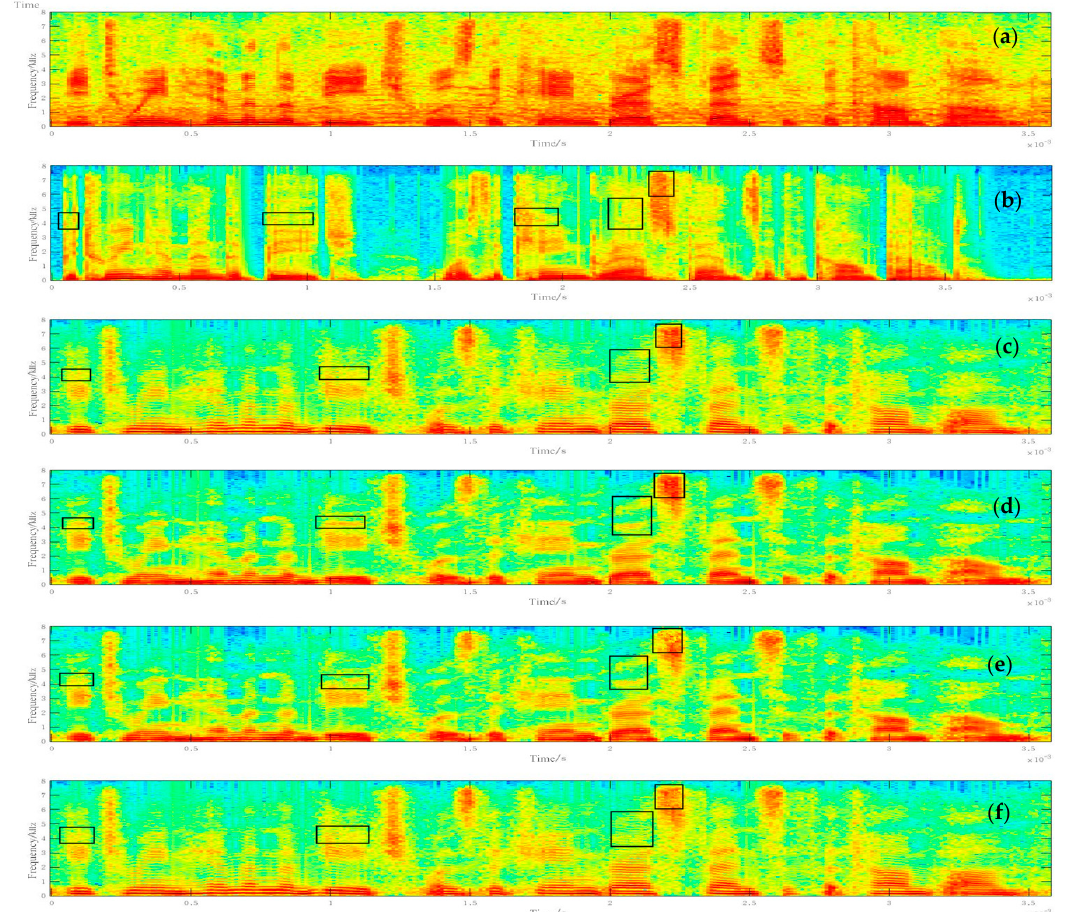
Figure 6. Spectrogram of the methods of voice conversion: ( a ) source voice with babble noise at 15 dB, ( b ) clean target voice, ( c ) BLSTM conversion, ( d ) the proposed method, ( e ) DIFFGMM conversion, and ( f ) GMM conversion.